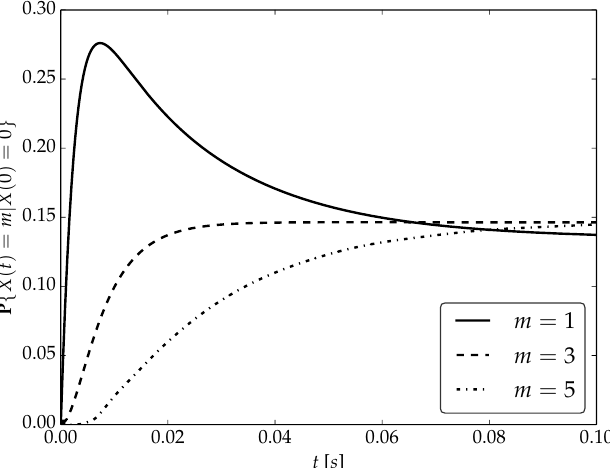
Figure 4. Transient probabilities P 20 ms.